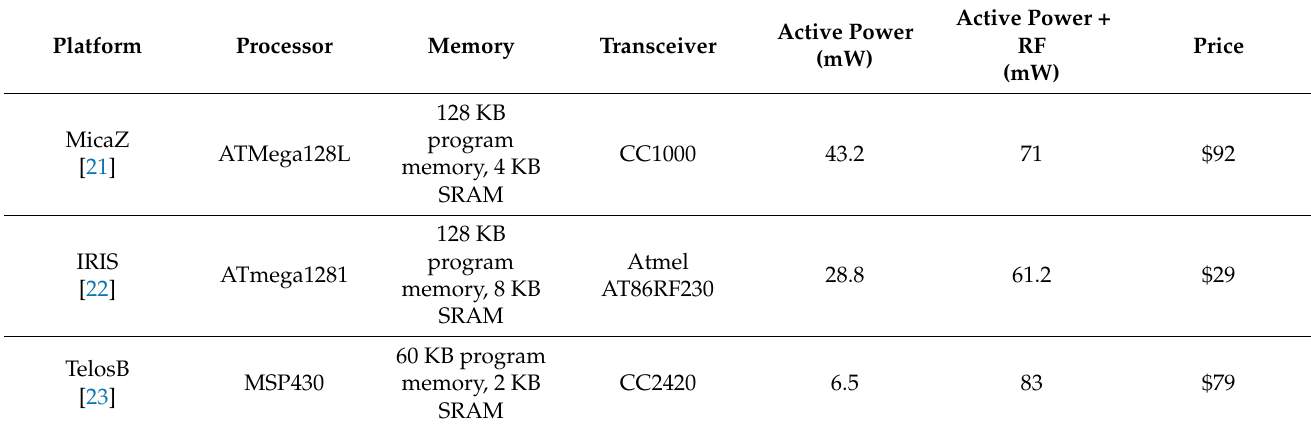
Table 1. Microcontroller-based low-power platforms.